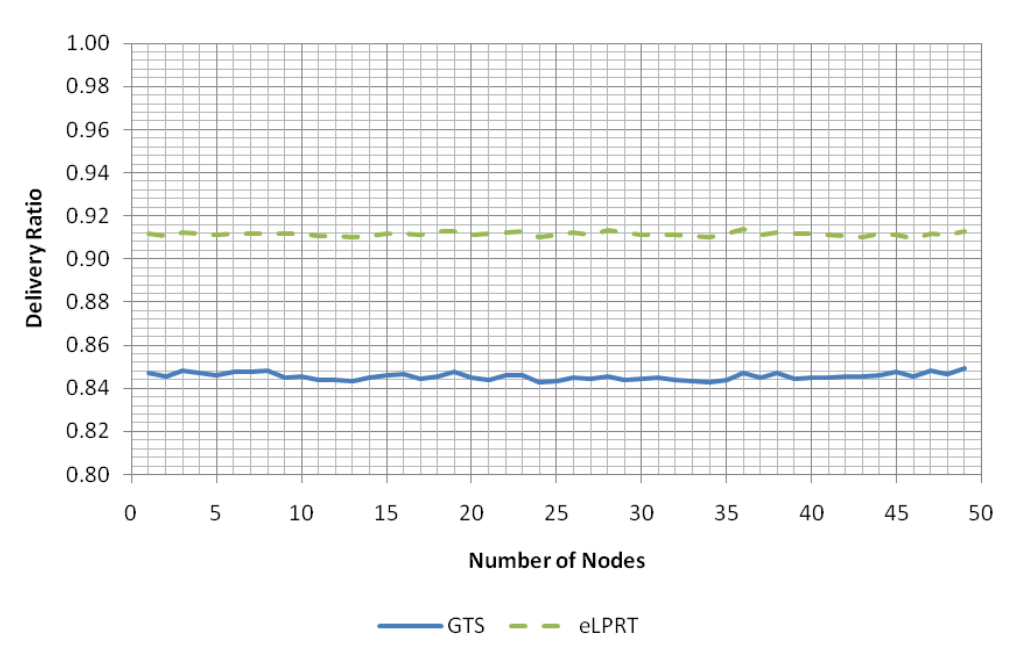
= 10 −2 and without bad